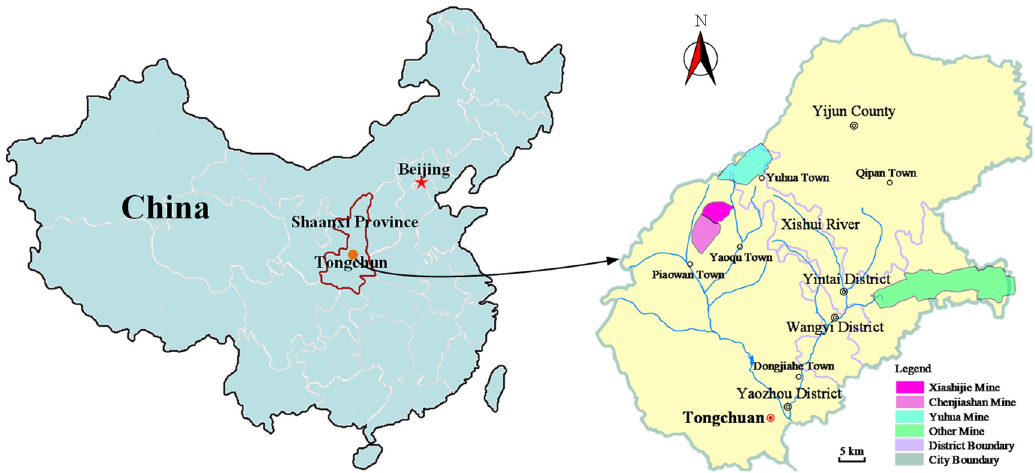
Figure 8. Location of Xiashijie coal mine.